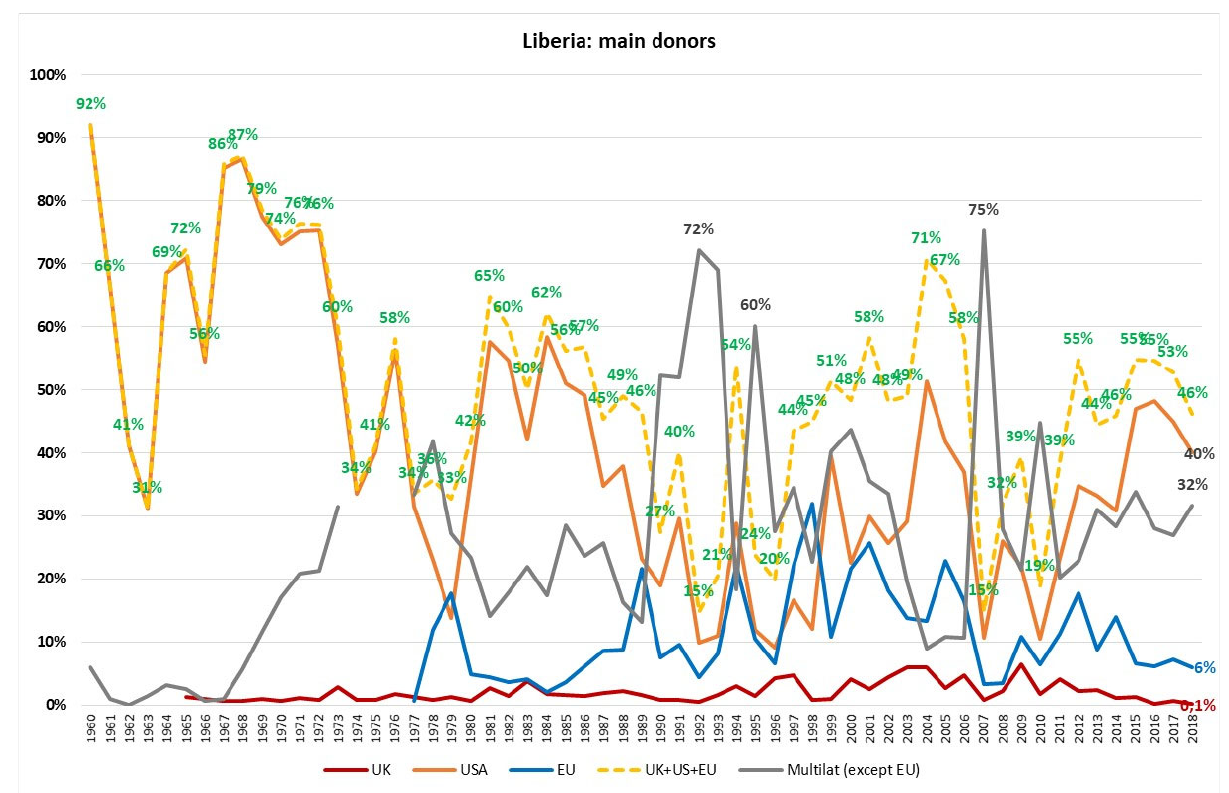
Figure 7. Main donors to Liberia. Source: Authors’ elaboration with data from OECD ‐ DAC Table 2a: net ODA total net disbursements in constant USD, 2018.